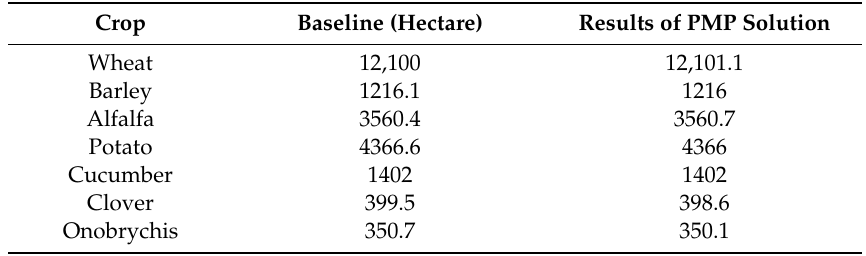
Table 2. Comparison of under cultivation area of base model and results of calibrated positive mathematical programming (PMP) model